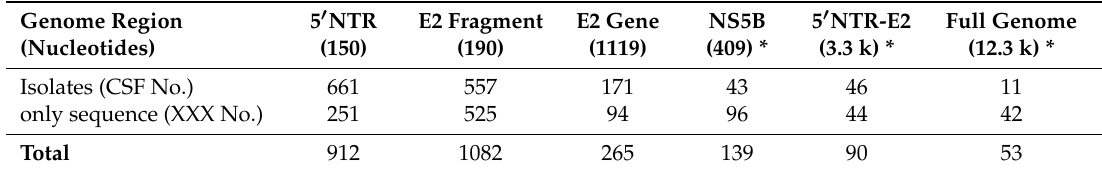
Table 1. Overview on total number of sequence data sets in the classical swine fever (CSF) sequence